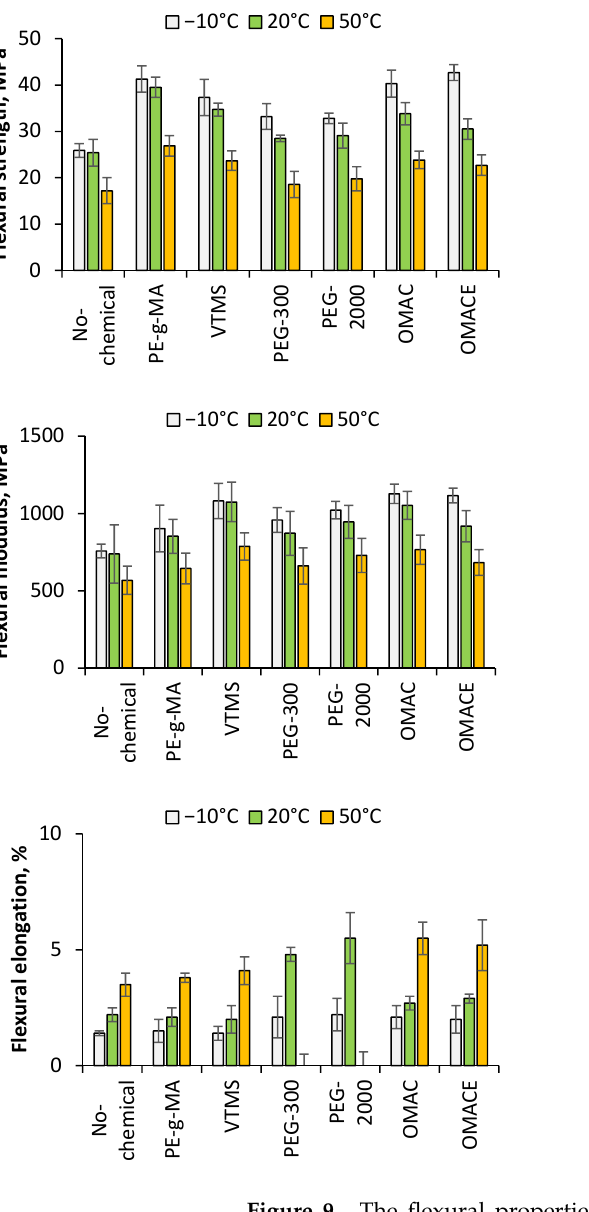
Figure 9. The flexural properties of nano ‐ cellulose reinforced PLA composites and the property change.